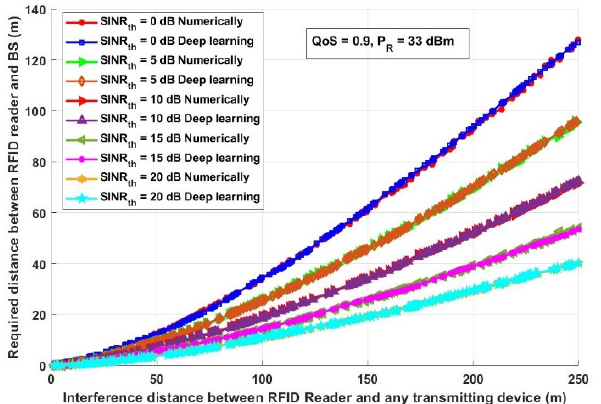
Figure 7. Interference distance between an RFID reader and any transmitting devices (m) versus required distance between RFID and BS (m).